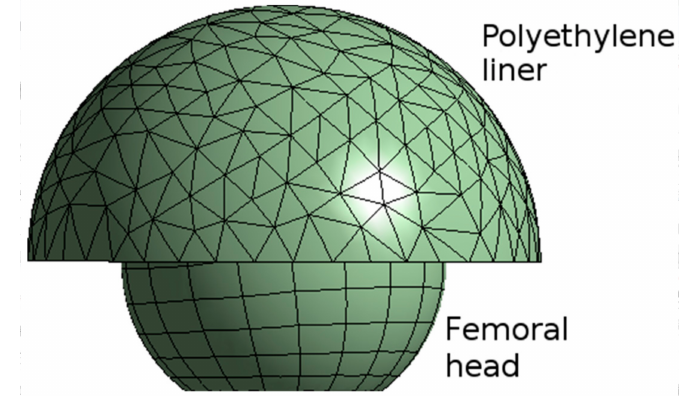
Figure 1. Mesh model of the femoral head and the polyethylene